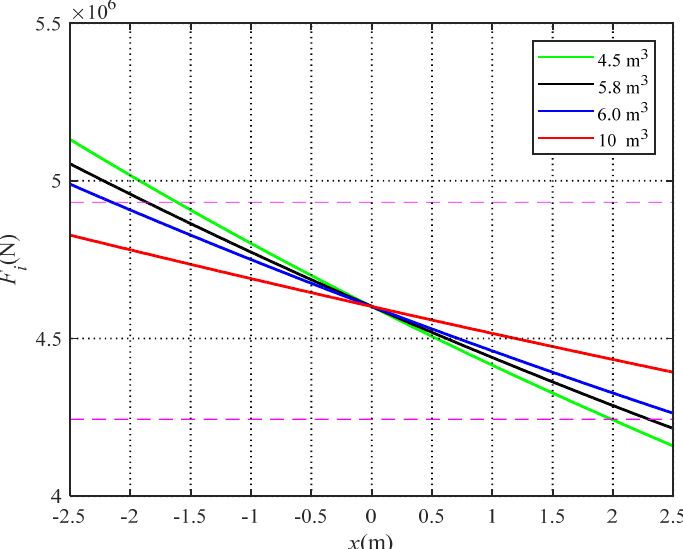
Table 1. External loads and Spring forces at x = 2.5 and x = − 2.5.